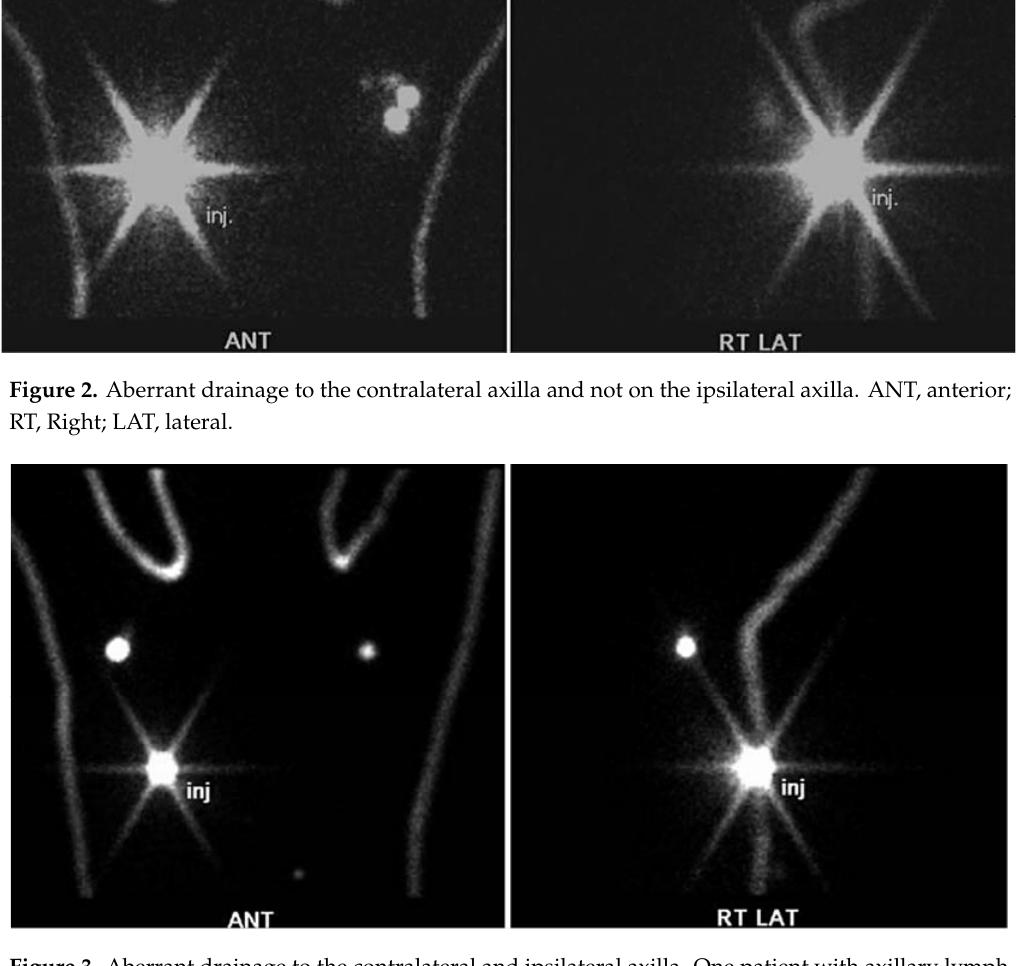
Figure 3. Aberrant drainage to the contralateral and ipsilateral axilla. One patient with axillary lymph node metastasis experienced recurrence on the flap after a skin-sparing mastectomy with a deep inferior epigastric perforator flap. Five patients underwent a dual method approach and four underwent radioisotope assessment only to detect the SLNs. The median number retrieved lymph nodes was 2.67 (range 1–4). None of the patients showed contralateral axillary metastasis in cases with isolated IBTR in the absence of clinically suspicious metastasis on the contralateral axilla.